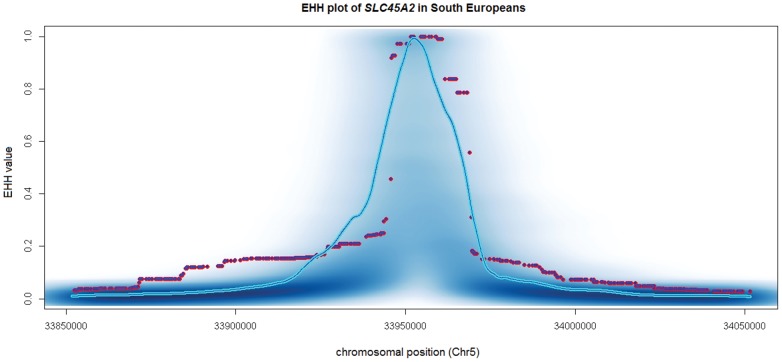
EHH analysis of the 1KGP South European samples.Simulated EHH values for the 374F haplotype using the demographic model of Gutenkunst et al. (2009). Shades of blue correspond to a smoothed color density representation of the scatter plot of all EHH simulations for each region. Blue darkness is proportional to the density of points in that vicinity. The continuous blue line corresponds to the 95th percentile of the distribution. Purple dots correspond to the observed values from the 1KGP data for South Europeans.